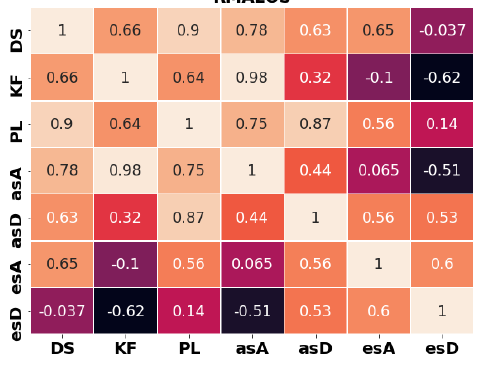
(a) Before normalization for RMa LoS.